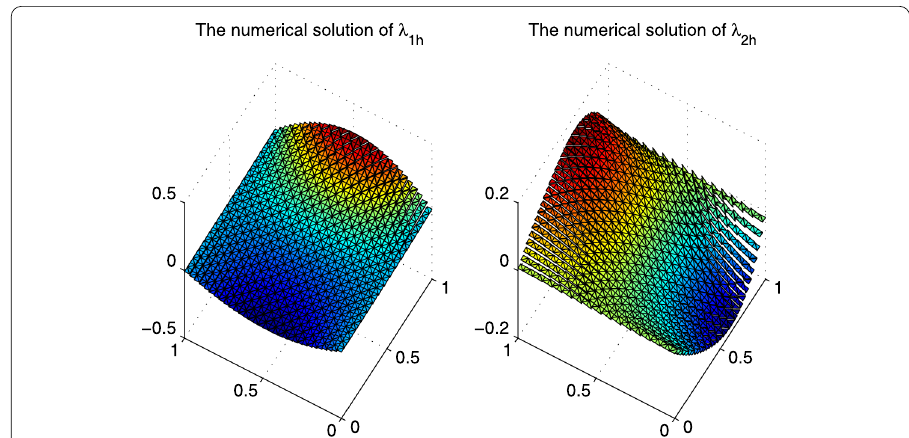
Figure 7 The numerical solution of λ h = ( λ 1 h , λ 2 h